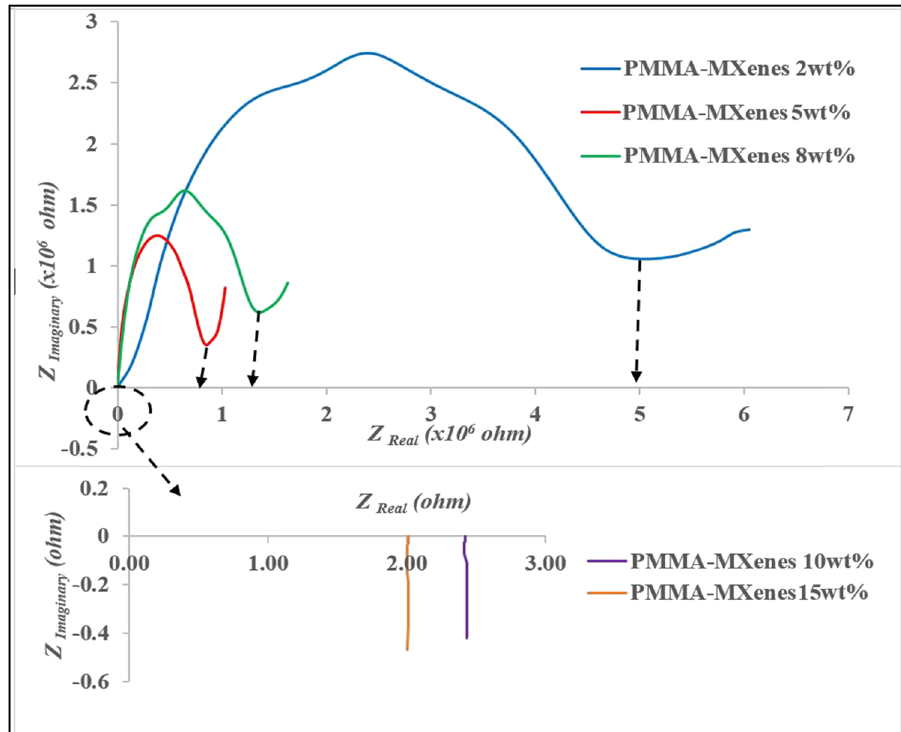
Figure 11: EIS were recorded at room temperature for all samples. An arrow indicates the magni fi ed EIS of the samples seen in a relatively narrow range of Z Real components.